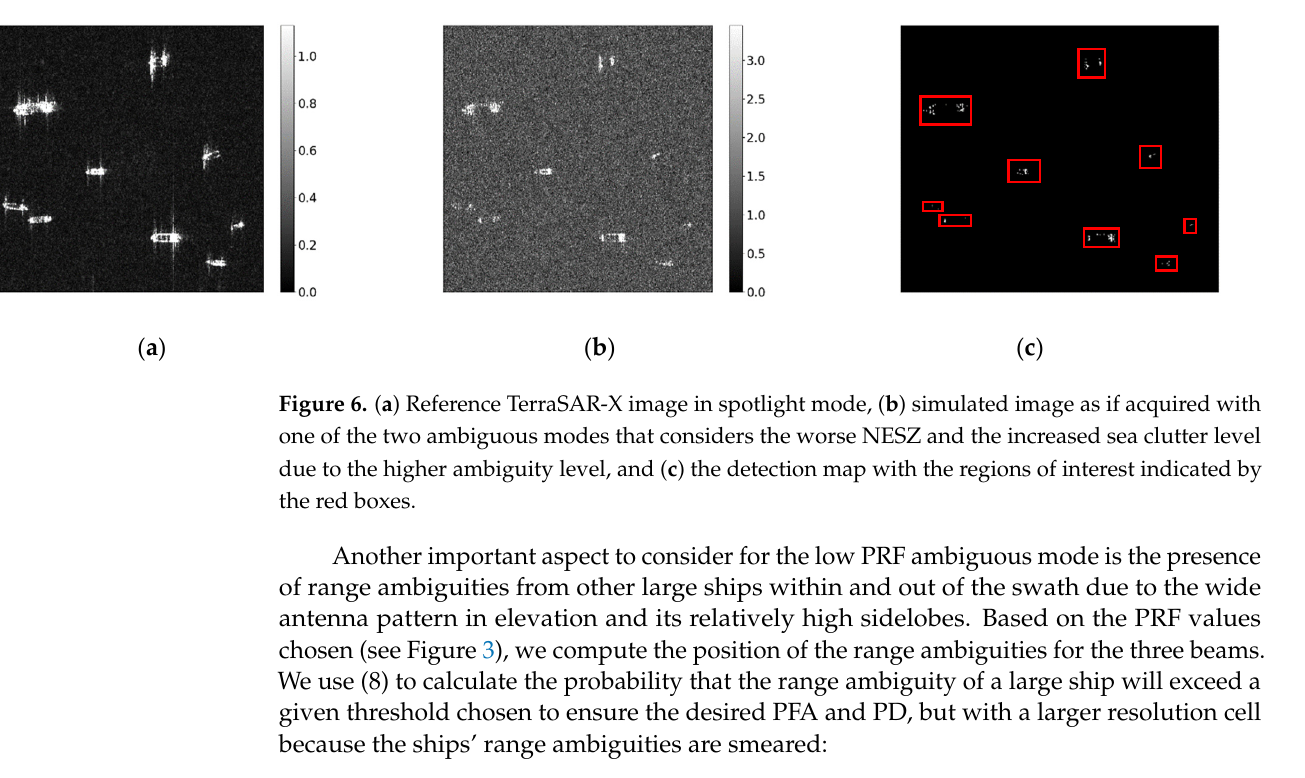
Figure 5. Probability of detection of a small ship of 21 m × 6 m size ( a ) for the near range beam (blue curve) and far range beam (red curve), which cover a 120 km ground swath each, and ( b ) for the beam, which covers a 240 km ground swath. The 120 km ground swaths and the 240 km ground swath are highlighted.